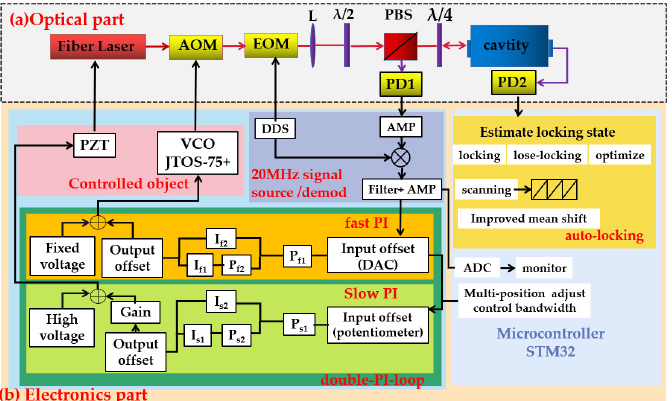
Figure 1. ( a ) Schematic diagram of the 1550 nm ultra-stable laser auto-locking system; ( b ) schematic diagram of the electronic control system. AOM, acoustic-optical modulator; EOM, electro-optical modulator; L, lens; λ /2, half-wave plate; PBS, polarization beam splitter; λ /4, quarter-wave plate; PD, photo-detector; DDS, direct digital synthesis; slow PI, slow proportional–integral controller; fast PI, fast proportional–integral controller .